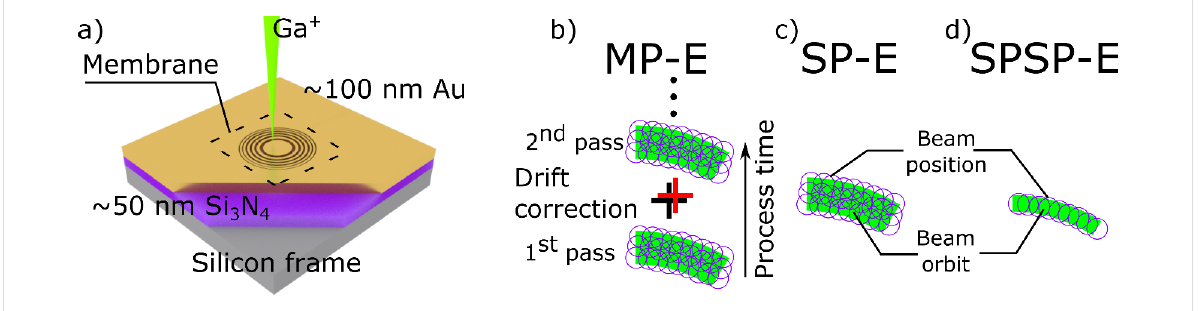
Figure 1: a) For the fabrication of an IBL FZP first, a ca. 100 nm gold layer is deposited on a commercial Si 3 N 4 membrane substrate of about 50 nm thickness. Then, the FZP pattern is written in the gold film using a focused Ga + ion beam. Several fabrication strategies are shown in b), c) and d).